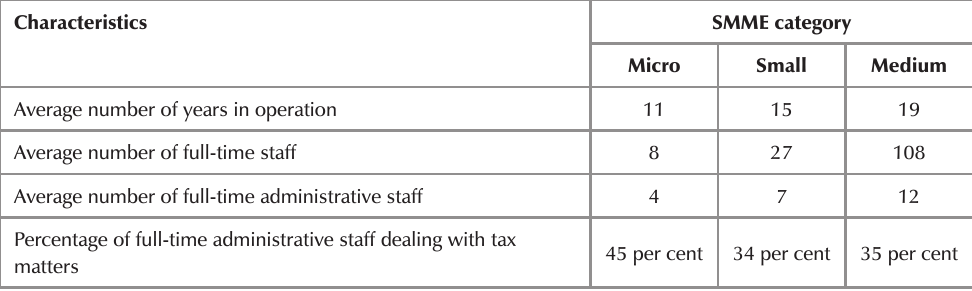
Profile of participating business services SMMEs by selected characteristics